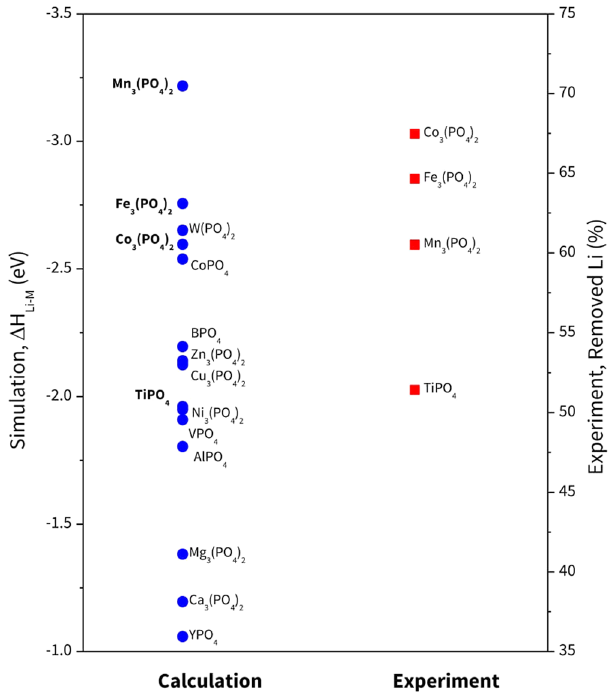
Figure 3. Comparison of Li-removal reactivity from calculations and experiment. Calc denotes that their values are obtained from the descending order of Δ H Li-M . MPs enclosed with squares indicate the materials that are compared with